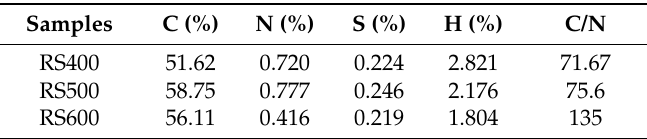
Table 1. Elements analysis of